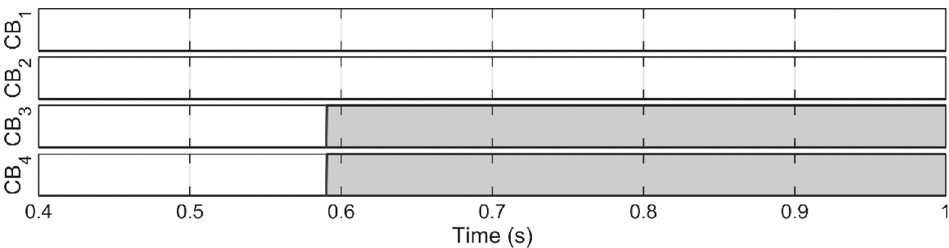
Figure 10. Relay trip signals in case DCRs operate normally: ( a ) relays in HTS 1 ; ( b ) relays in HTS 2 .